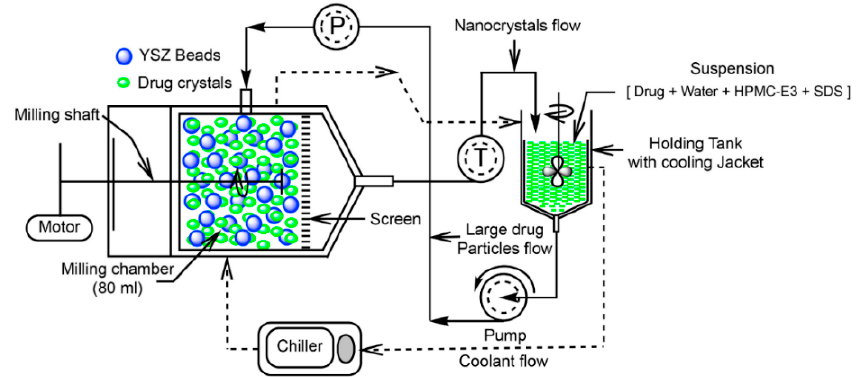
Figure 1. An example of preparation of drug nanocrystals in a recirculation model with hydroxypropyl methylcellulose (HPMC) and sodium dodecyl soleplate (SDS) as stabilizers. YSZ: yttrium-stabilized zirconium. Reprinted from [35] by Creative Commons Attribution 4.0 International Public License.